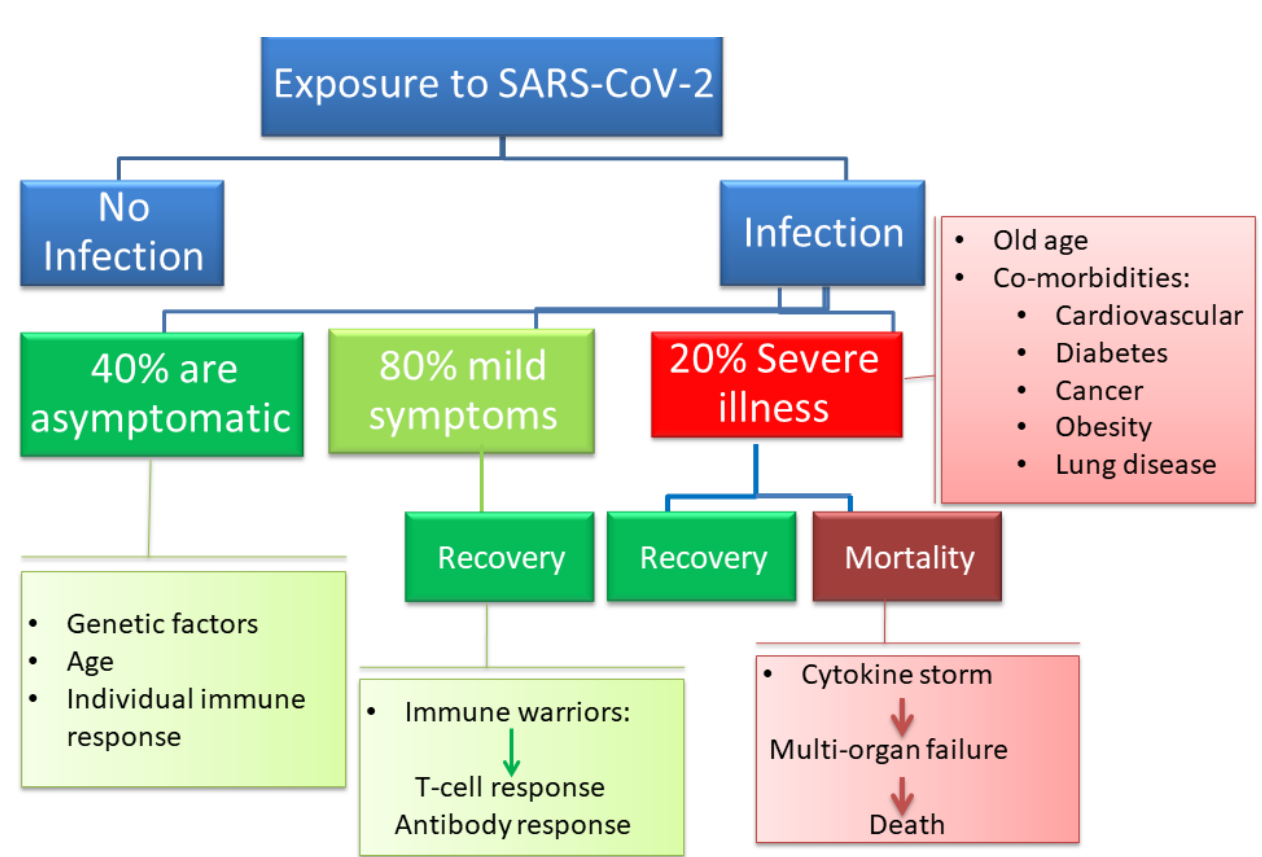
Figure 1. The clinical spectrum of coronavirus disease 2019 (COVID-19) ranges from no or mild symptoms that do not require hospitalizations to severe pneumonia and respiratory failure that can lead to death, especially in aging patients and patients with comorbidities.